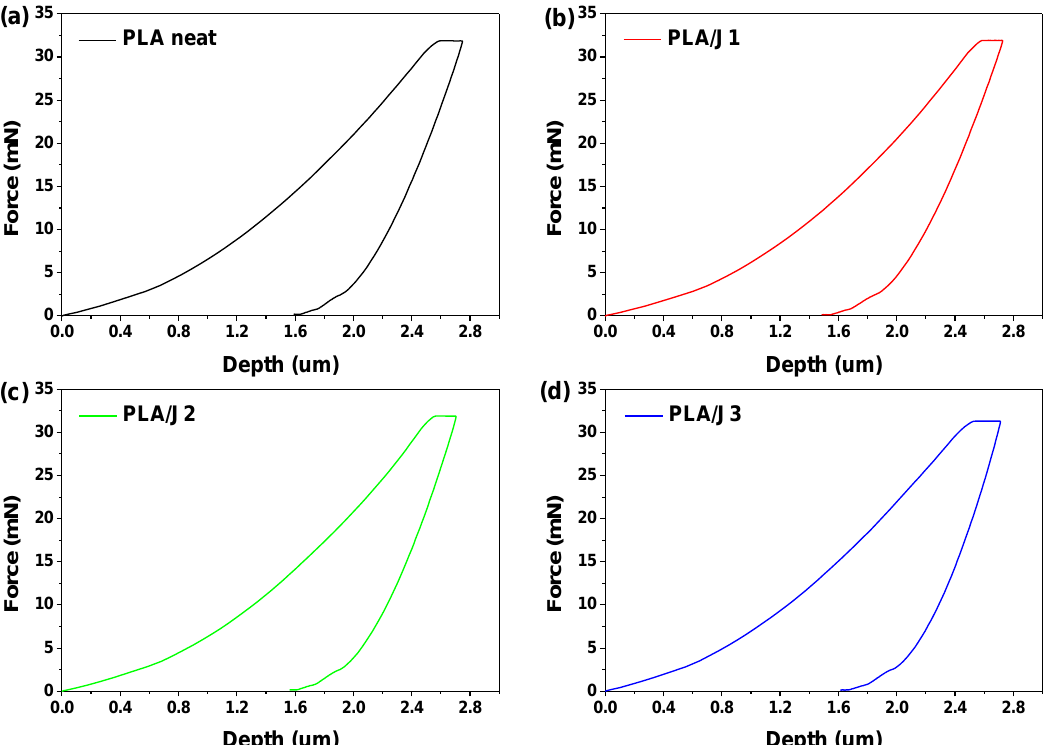
Figure 5. Typical load–depth nanoindentation curves for ( a ) PLA neat, ( b ) PLA/J1, ( c ) PLA/J2, and ( d ) PLA/J3.